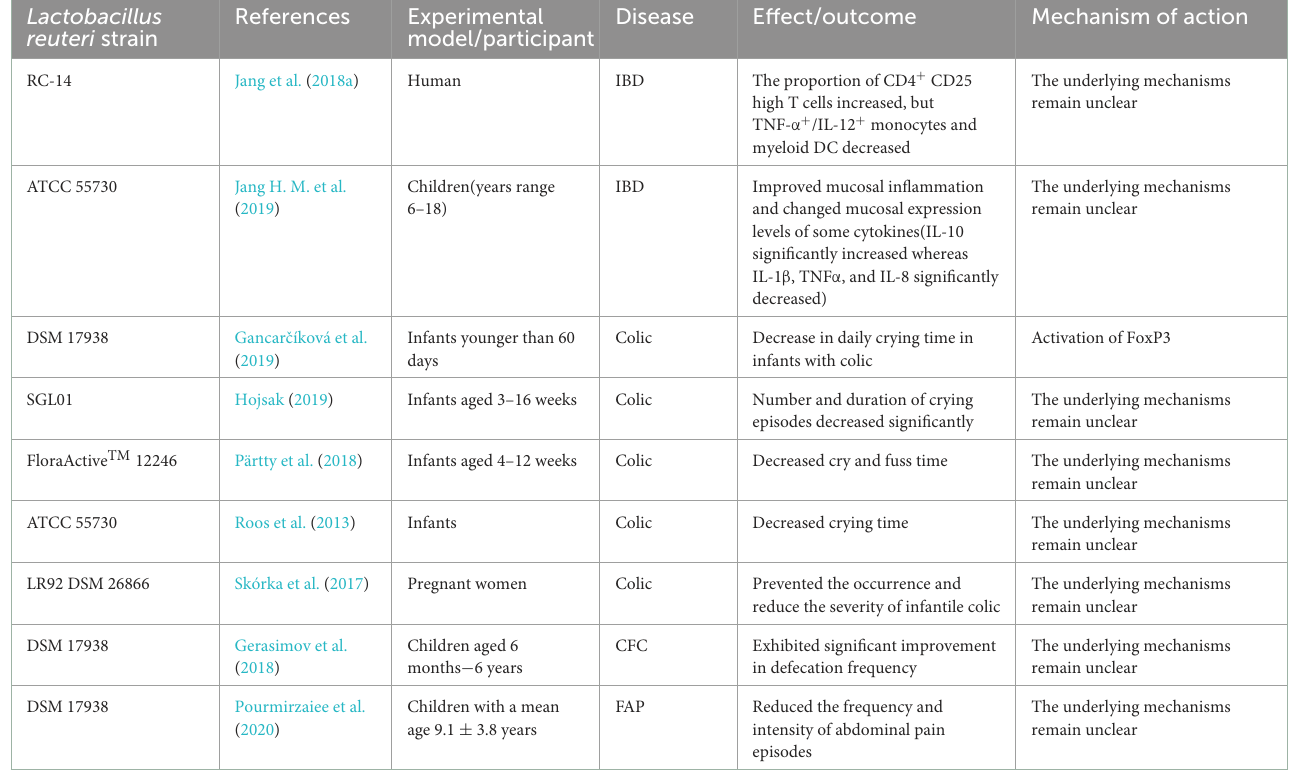
TABLE 3 Therapeutic efficacy and potential mechanisms of Lactobacillus reuteri strains in various intestinal diseases in humans. Lactobacillus reuteri